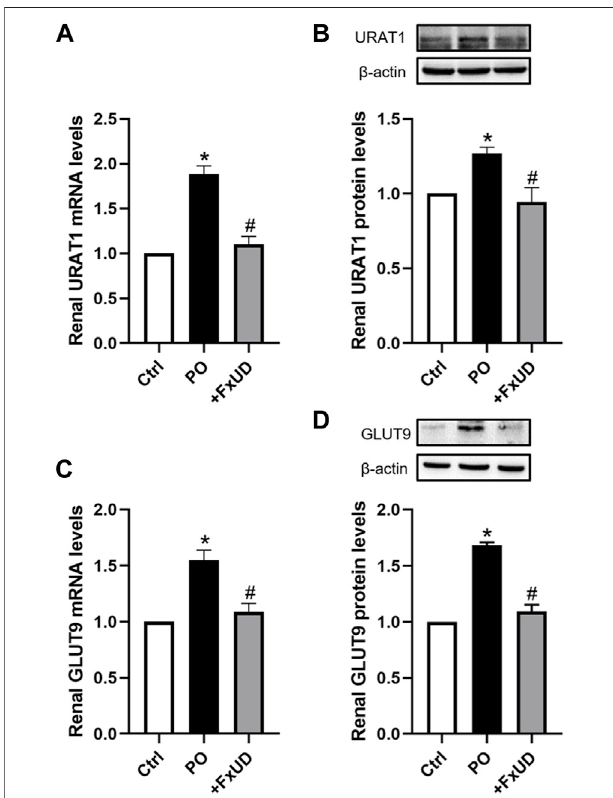
FIGURE 5 | FxUD reduces renal reabsorption of uric acid in hyperuricemic mice. (A) mRNA and (B) protein levels of URAT1 in the kidney. (C) mRNA and (D) protein levels of GLUT9 in the kidney of mice. Values are expressed as the means ± SD ( n (cid:1) 4 – 5). * p < 0.05 vs. Ctrl, # p < 0.05 vs.